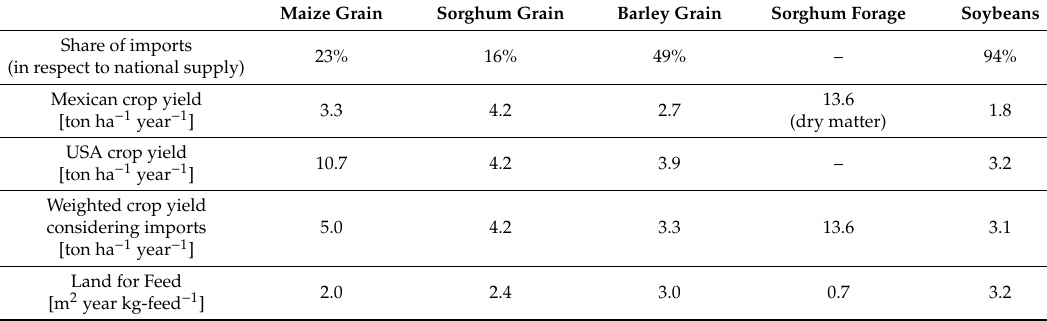
Table 1. Average crop yield for the main five feed crops and the contribution of imports. Source data: Food Balance Sheets (imports) [7]; crop yield values of 2014 from FAO [7] and SIAP [24]. Maize Grain Sorghum Grain Barley Grain Sorghum Forage Soybeans